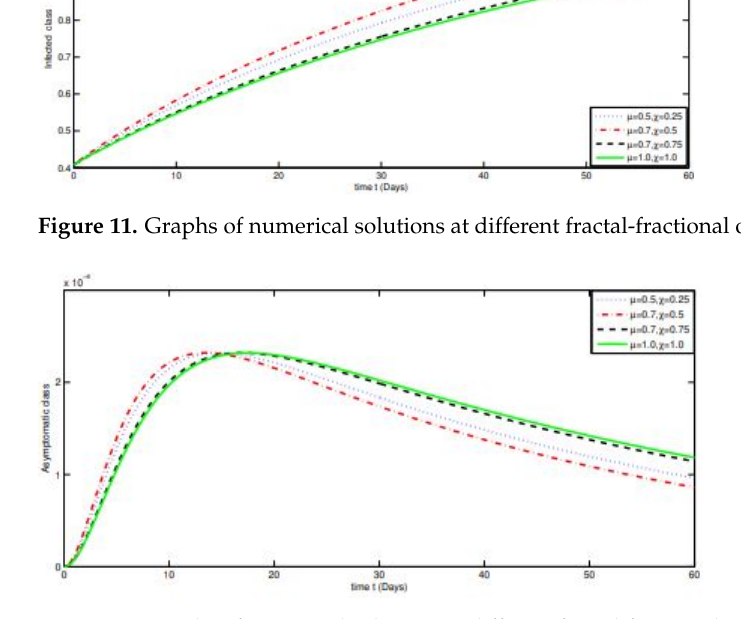
Figure 12. Graphs of numerical solutions at different fractal-fractional order for Asymptomatic